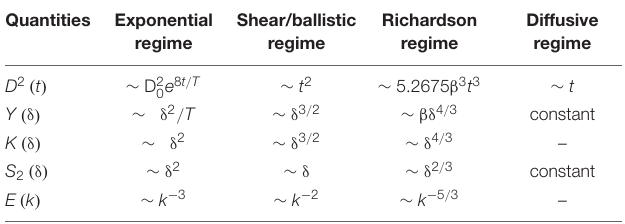
TABLE 2 | Classical relative dispersion regimes. Where the parameters T and β are calculated from the